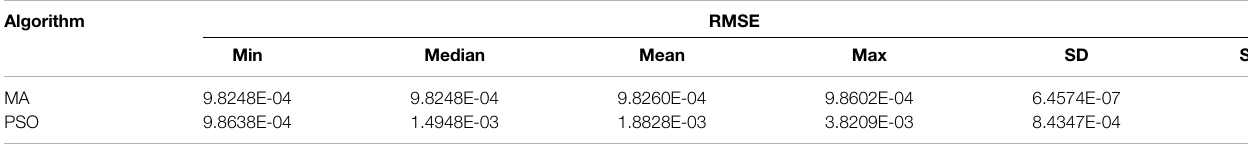
TABLE 6 | Statistical results of the RMSE obtained by various algorithms for the TDM.